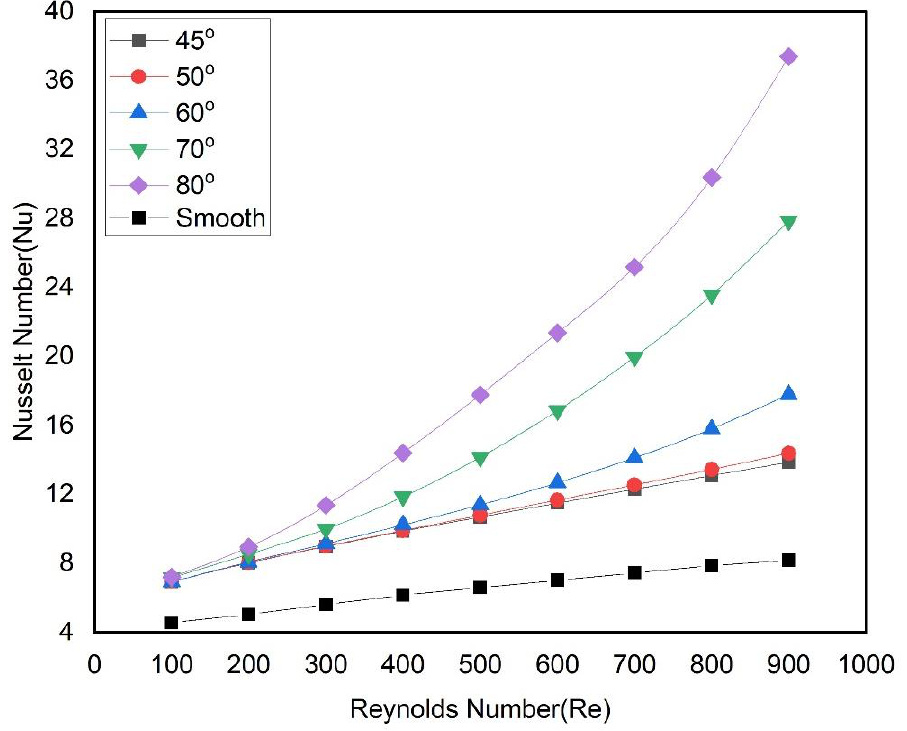
Figure 9. Nusselt numbers and Reynolds numbers in relation to various angles.